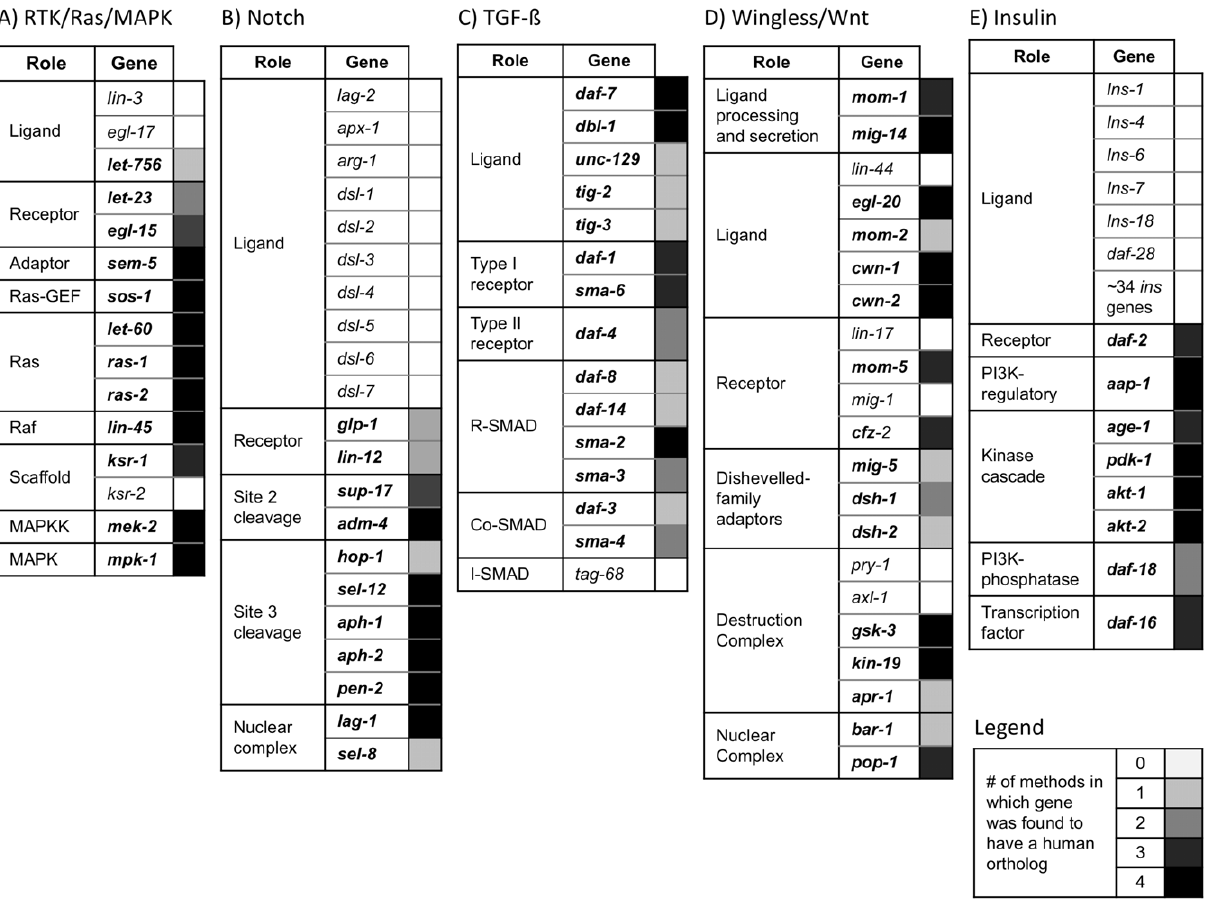
Figure 3. OrthoList coverage of conserved signaling pathways. Genes in bold are found by at least one orthology-predicting program, and thus included in OrthoList. The source data for this figure can be found in Table S5. A) RTK/Ras/MAPK pathway (reviewed in [34]). Note that ras-1 and ras-2 have not been defined functionally, although they are highly conserved. B) Notch pathway (reviewed in reviewed in [32]). C) TGF-ß pathway (reviewed in [33]). We note that tag-68 , was only defined by conservation and no phenotype has been associated with its loss. D) Wnt pathway (reviewed in [30]). Note that our analysis was restricted to the conserved, canonical Wnt pathway. E) Insulin pathway. We specifically highlight the six insulins ( daf-28 , ins-1 , ins-4 , ins-6 , ins- 7 and ins- 8), out of forty, that have been found (by overexpression, biochemical methods, RNAi or by existence